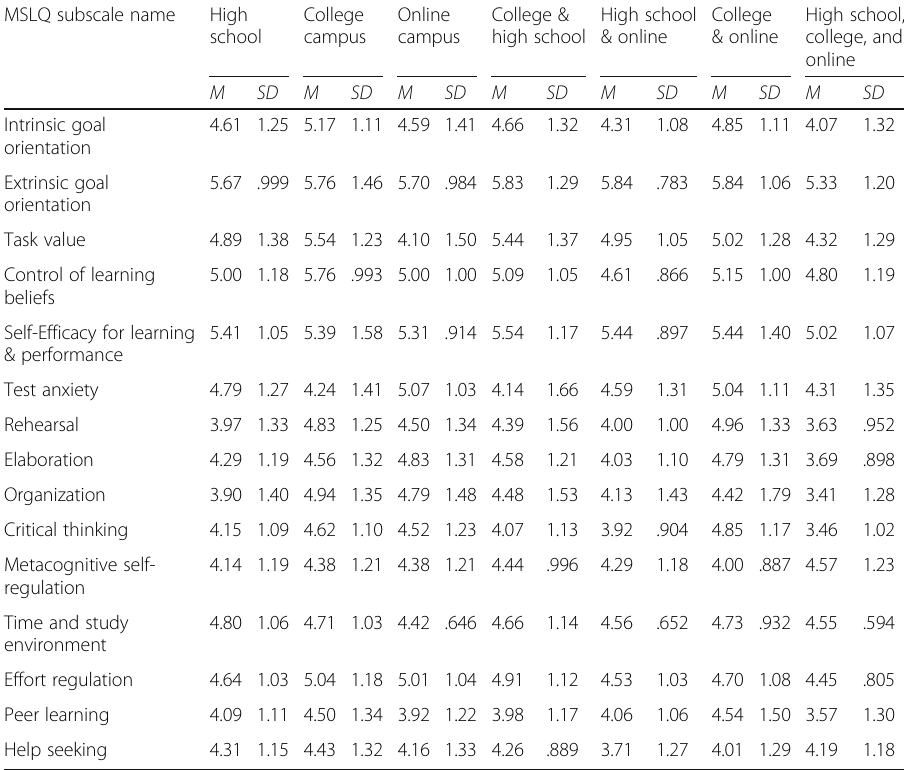
Table 3 Means and SD for MSLQ by campus location MSLQ subscale